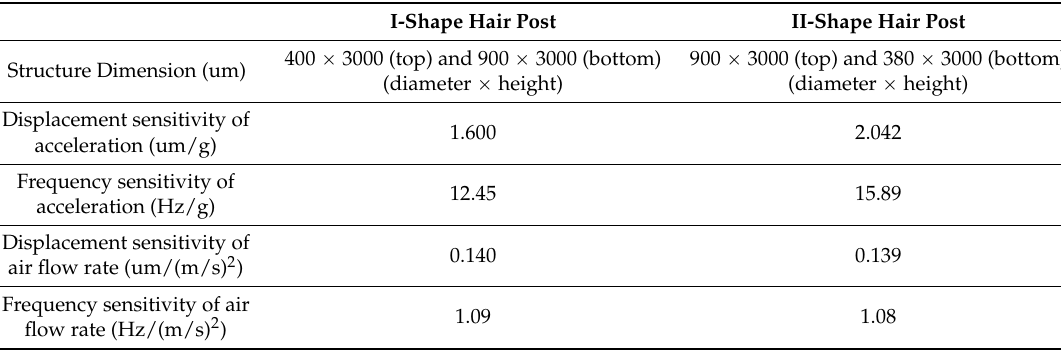
Table 5. Performance comparison of two kinds of hair